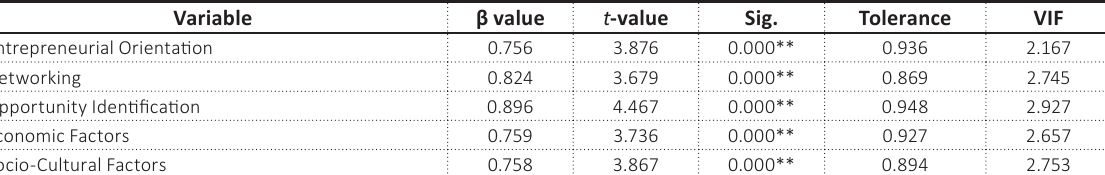
Table 3. Regression